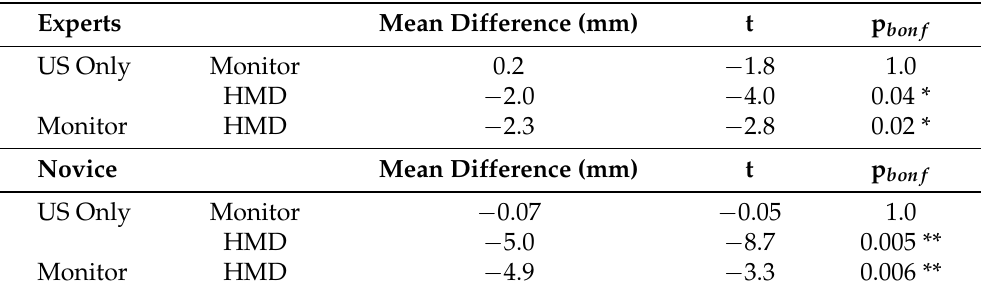
Table 2. Post-hoc test results following repeated measures ANOVA analysis for the distance from the final needle tip position to the closest point on the vessel wall for both experts and novices.